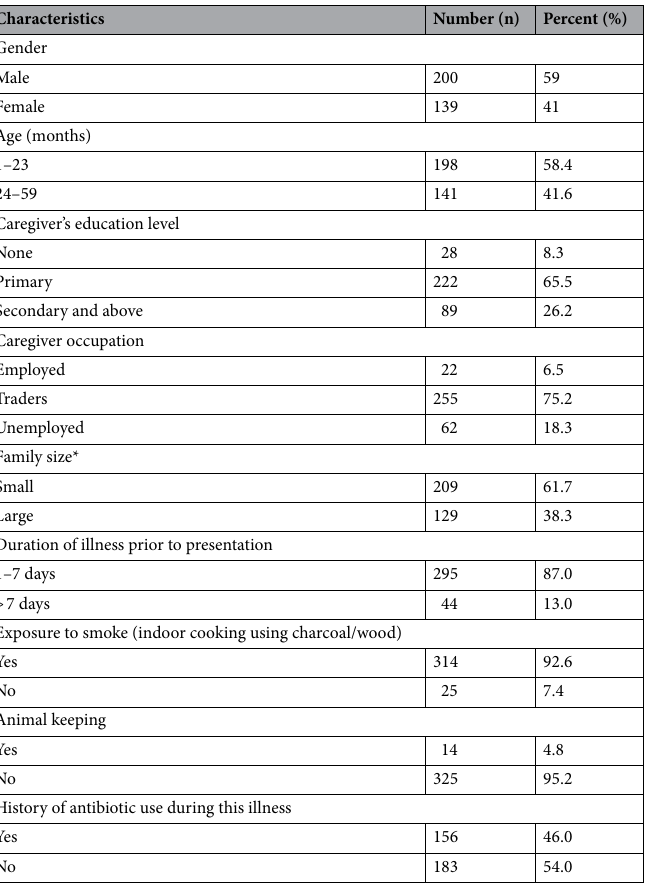
Table 1. Socio-demographic distribution for under five children with URTI in Mwanza